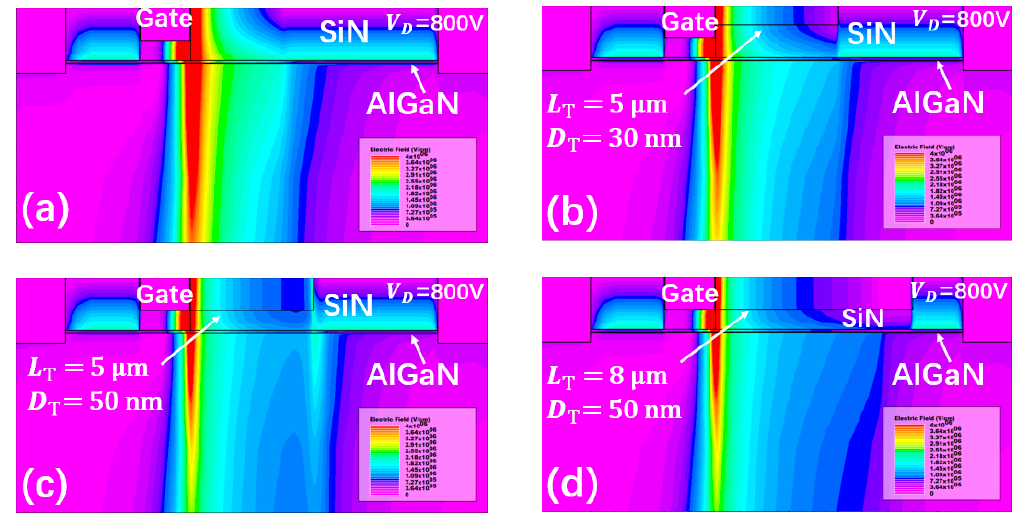
Figure 8. The simulated E-field distribution in ( a ) conventional UTB-HEMT, and ( b – d ) LCCT-HEMT with different LCCT configurations when the drain voltage is 800 V.